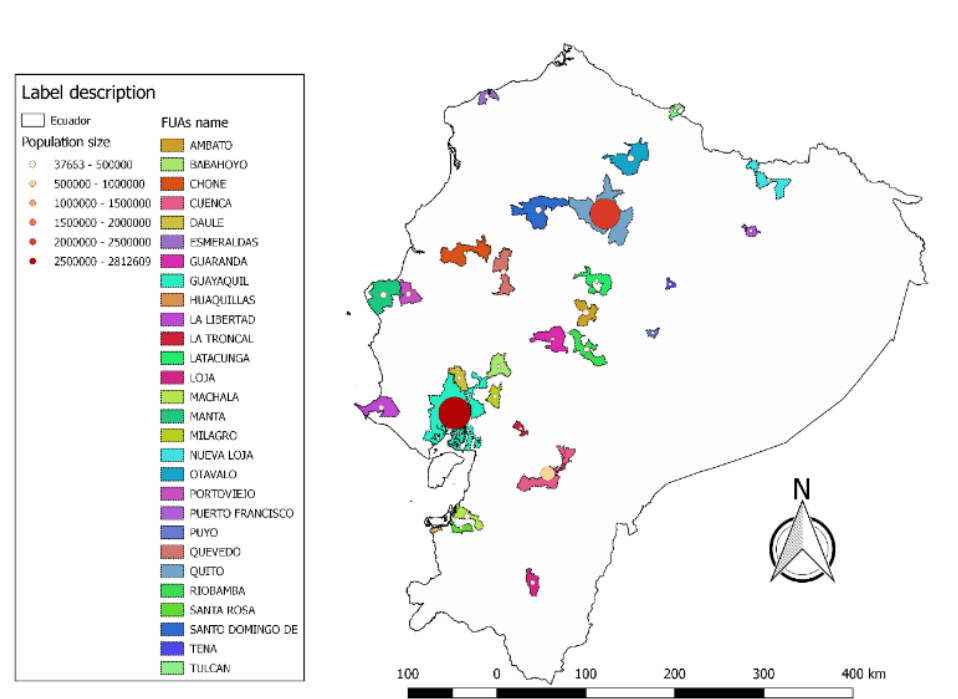
Figure 2: FUAs in Ecuador